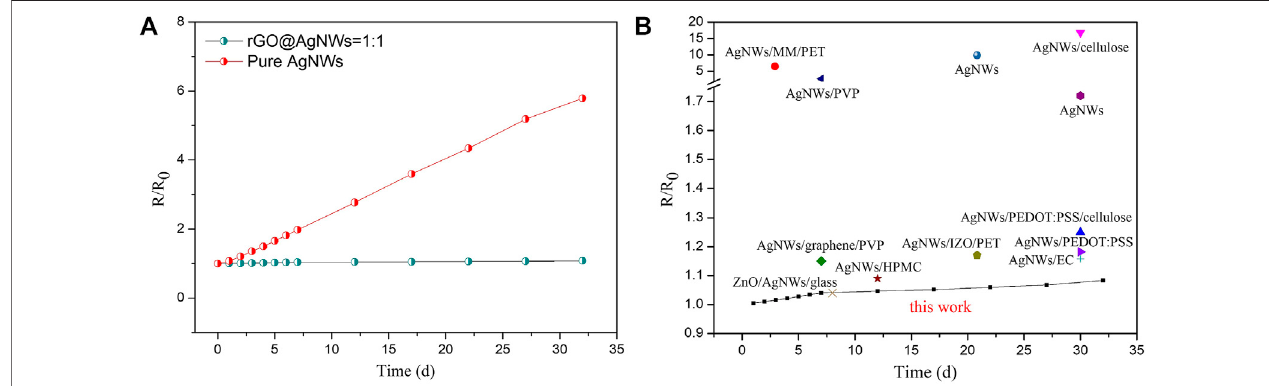
FIGURE6| TheR/R 0 variationsofrGO@AgNWspaperandpureAgNWs fi lmversustimeatair (A) ,comparisonoftheantioxidationpropertyofrGO@AgNWspaper with other AgNWs composite materials (B) .